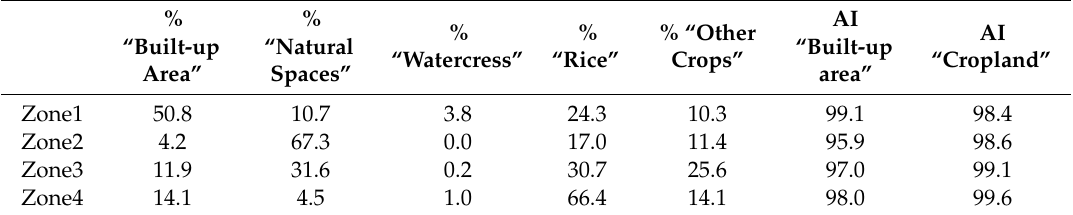
Table5. Averagevaluesperzoneforthesevenvariablesusedinthek-meansclustering. AI,aggregationindex. % % % “Natural “Built-up Spaces” Area”